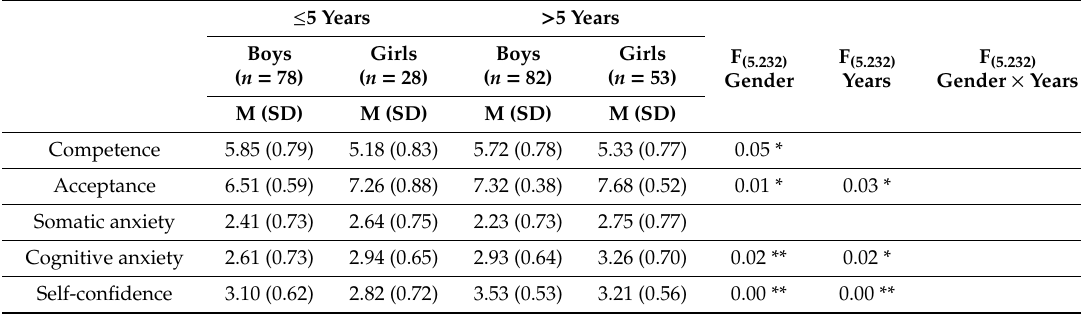
Table 4. Analysis of multivariate variance of resiliency resources and anxiety, according to gender and years of federated sport experience.